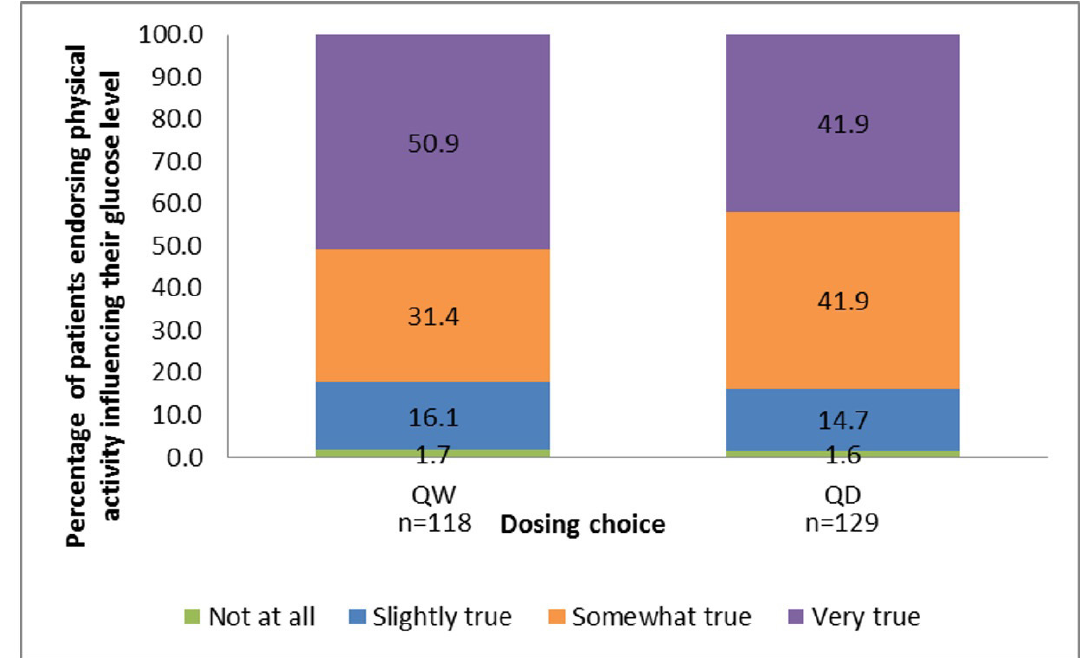
Figure 5. Dosing Preferences for Treatment Naive Groups of Patients with different Perceptions of Physical Activity influencing their Glucose